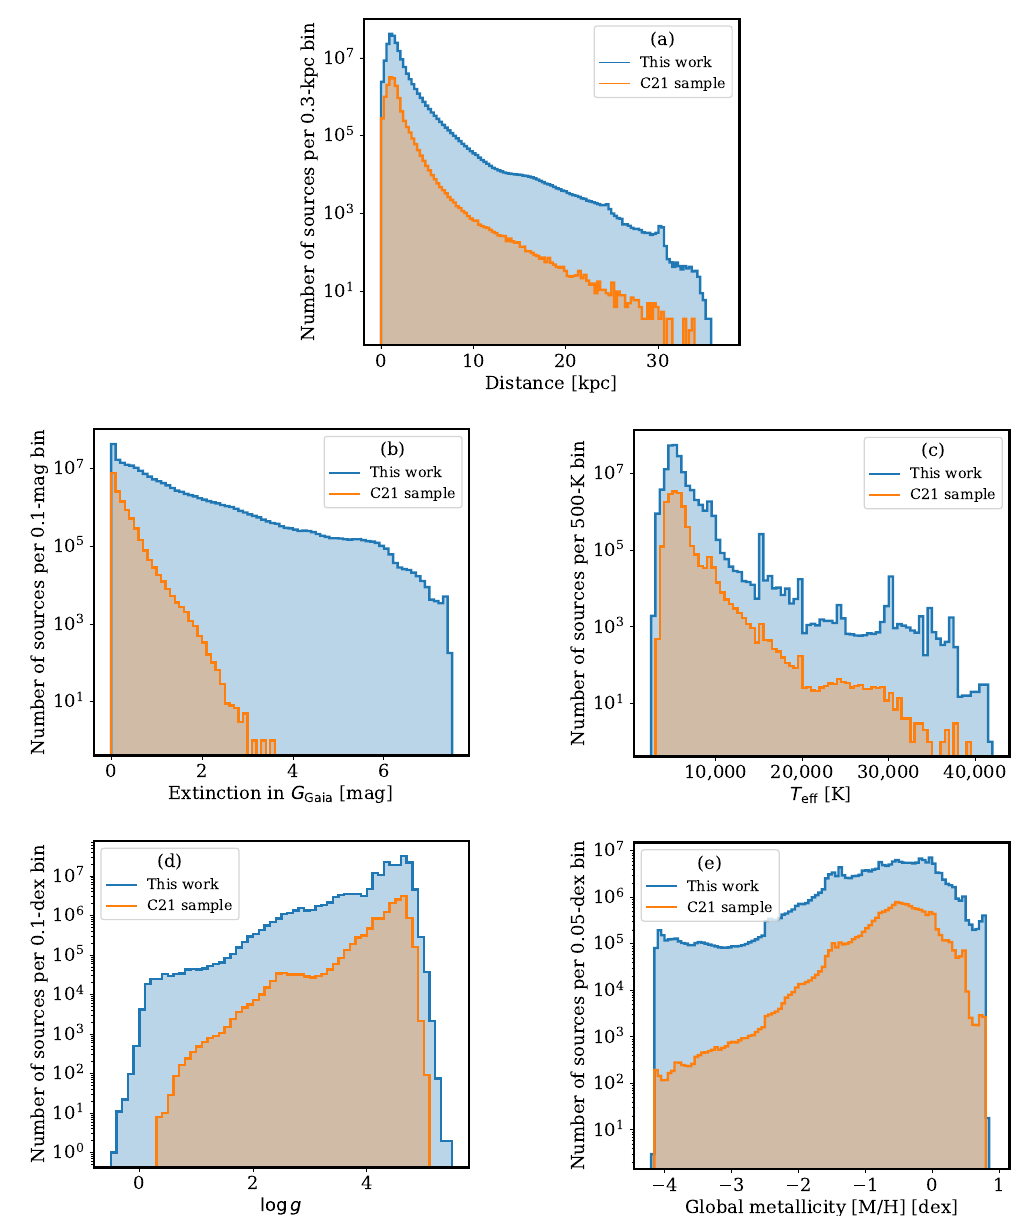
Figure 8. Comparison between the 200 M sample built in this work (blue histograms) and the C21 sample (orange histograms). The panels represent different parameters retrieved from the Gaia DR3 database, namely distance_gspphot (in kpc, panel ( a )) and extinction in the G Gaia band ag_gspphot (in magnitudes, panel ( b )) as well as typical stellar parameters, such as the effective temperature teff_gspphot (in K, panel ( c )), surface gravity logg_gspphot (logarithm of cgs units, panel ( d )) and global metallicity mh_gspphot (dex units, panel ( e